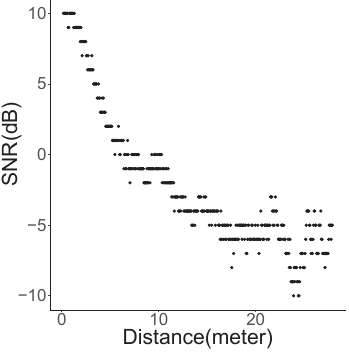
Figure 9. Received SNR of a slowly moving vehicle with beam angle ± 30 ◦